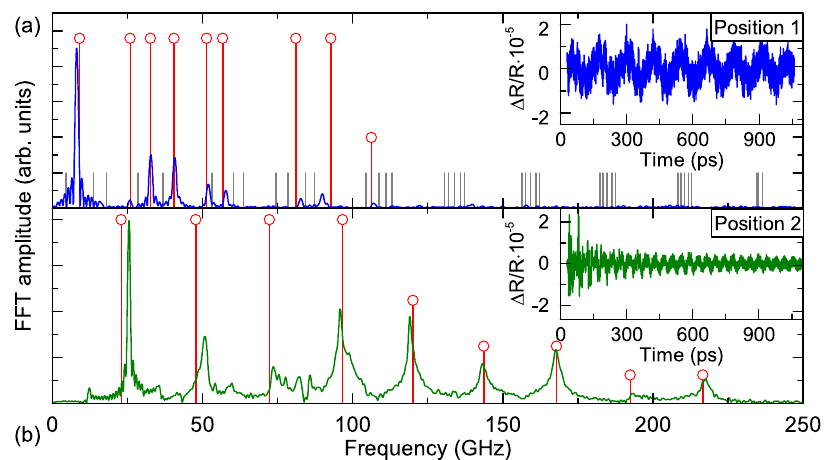
Figure 4. ( a ) The inset of the figure shows the extracted oscillations at position 1 of sample A r (with a number of 5 windings). In the main part of the figure the respective FFT is shown. The vertical lines in the FFT spectrum are the frequency modes obtained from calculations based on the transfer matrix method. The corresponding sound velocities are listed in the main text. ( b ) Extracted oscillations and respective FFT with calculated frequency modes for position